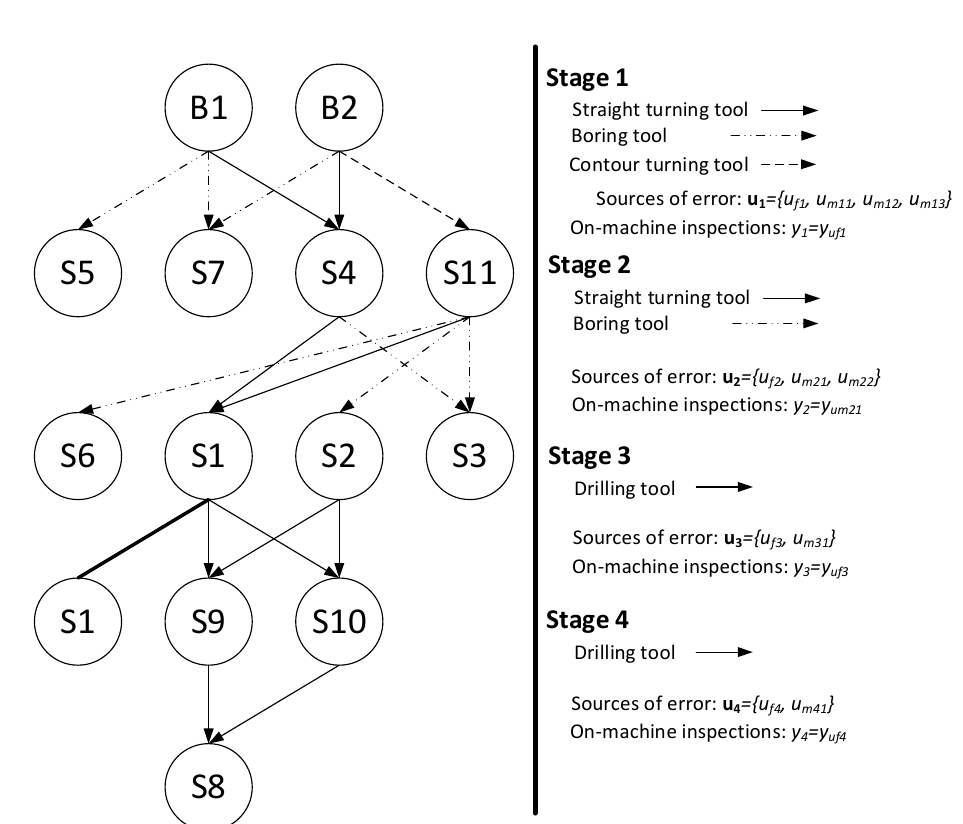
Figure 9. Rooted tree of the case study. B1–B2, raw surfaces; S1–S11, machined surfaces.